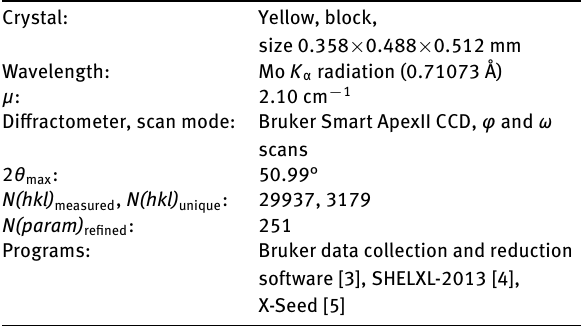
Table 1: Data collection and handling.